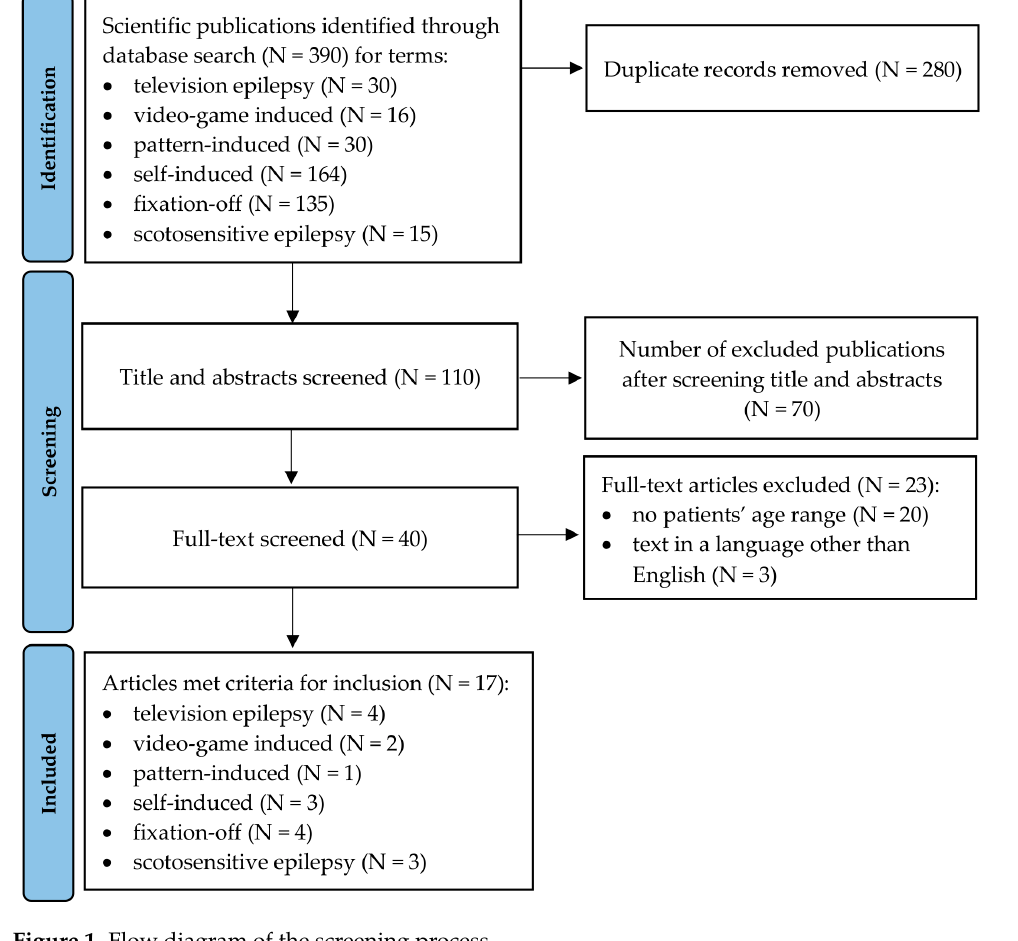
Figure 1. Flow diagram of the screening process.